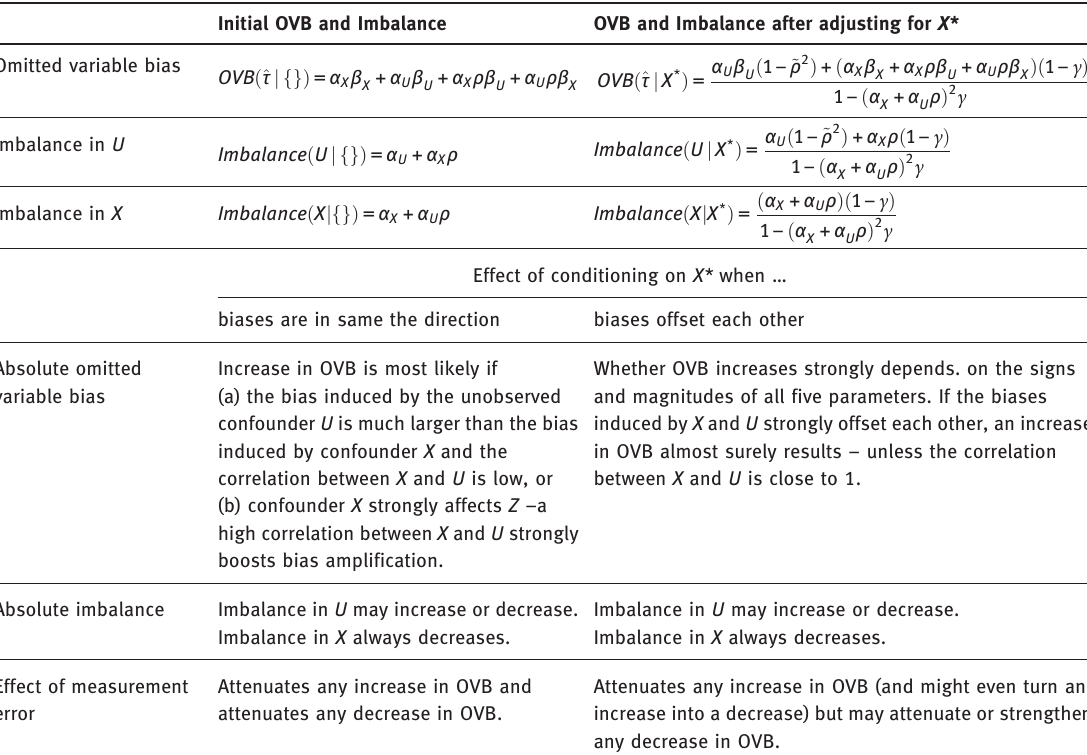
Table 2: Correlated confounders X and U : Omitted variable bias (OVB) and imbalance before and after adjusting for X* . Initial OVB and Imbalance OVB and Imbalance after adjusting for X* Omitted variable